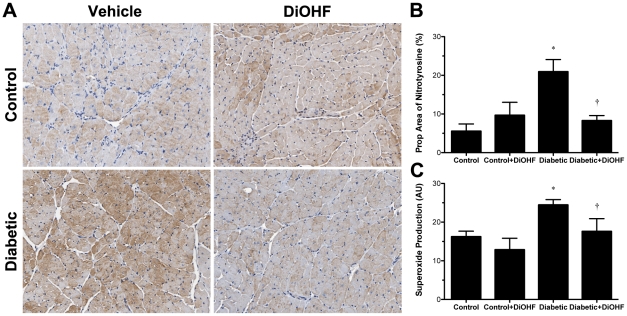
Measurements of oxidative stress.Representative images for the localization of 3-nitrotyrosine in LV tissues, as assessed by the proportional area of positive immunostaining in control and diabetic rats treated with or without DiOHF (A). The marked increase in positive immunostaining (brown region) for 3-nitrotyrosine in diabetic rats was reduced by DiOHF treatment. The amount of 3-nitrotyrosine was found to be comparable in control and control-treated Ren-2 rats (B). Original magnification ×200. (C) NADPH-activated superoxide production in LV tissues as measured by lucigenin-enhanced chemiluminescence. Data expressed as mean ± SE. *P<0.05 vs control (non-diabetic) rats; †P<0.05 vs diabetic rats.